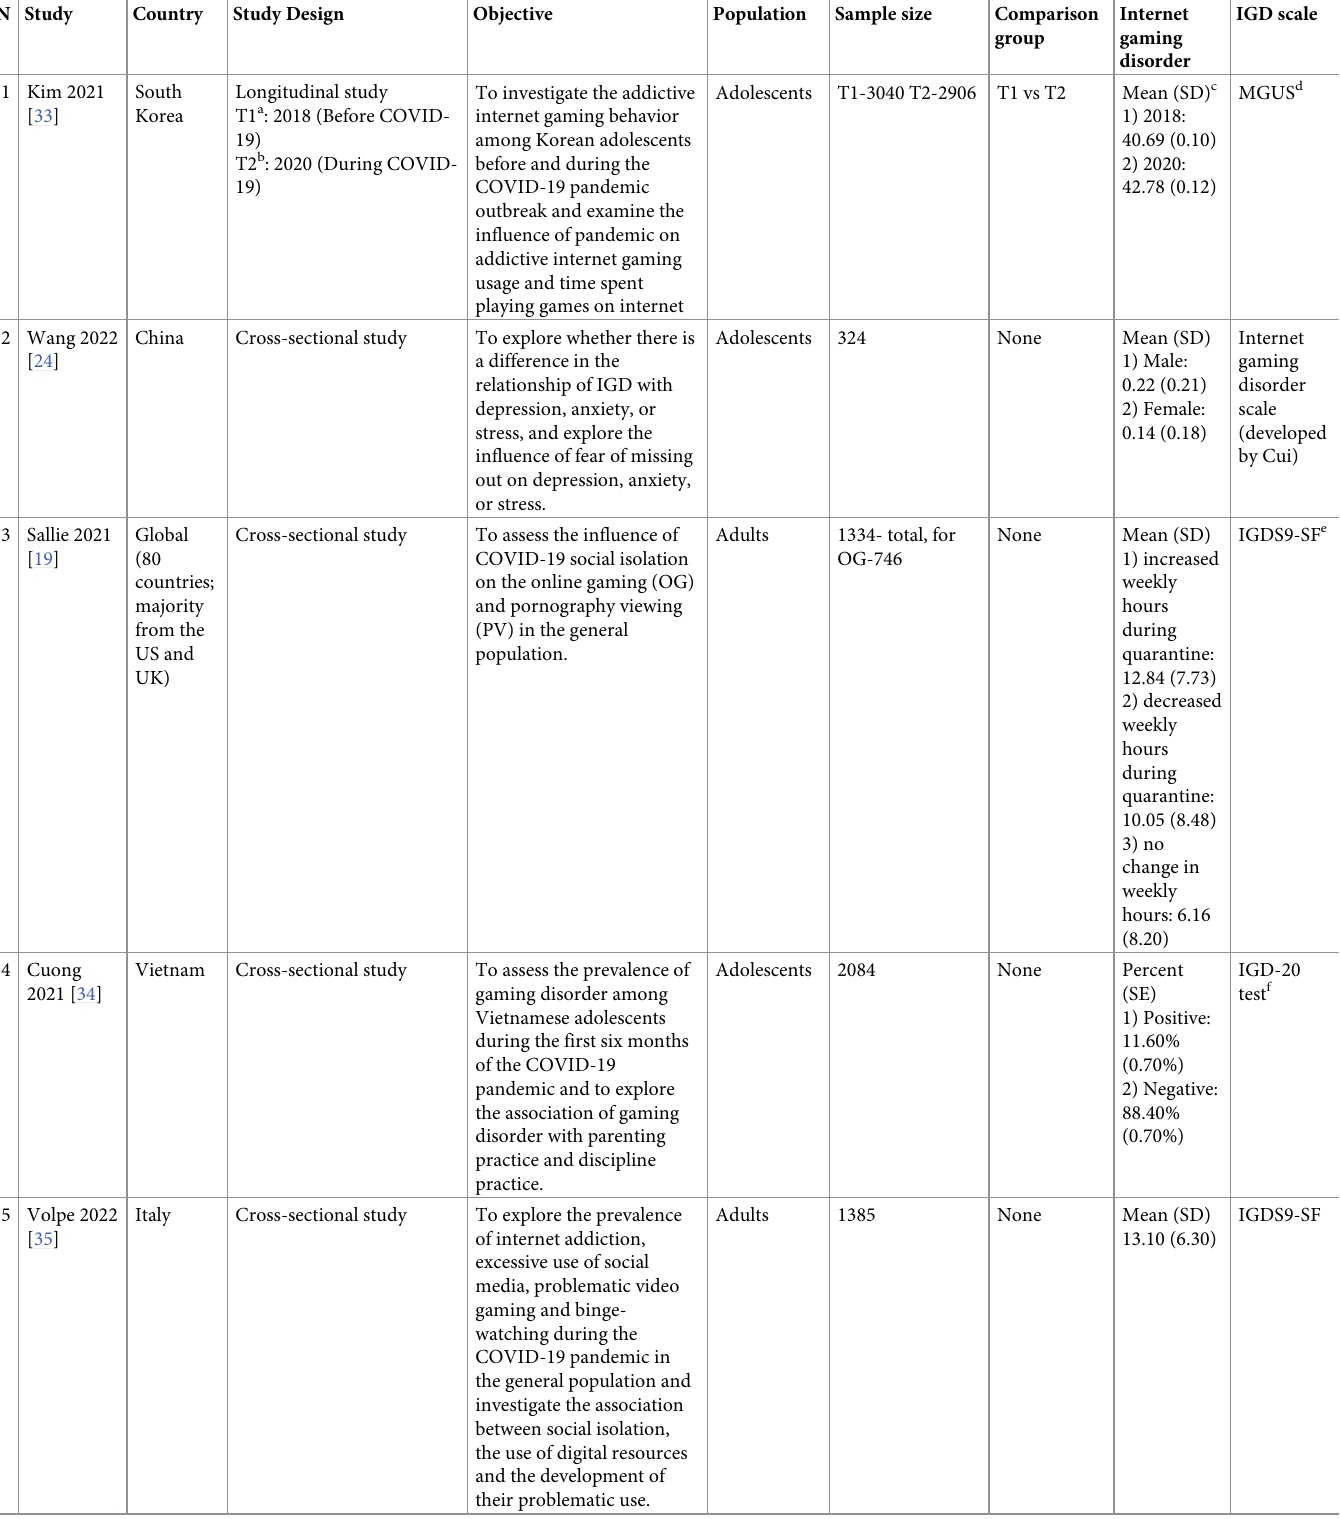
Table 1. Characteristics of the included